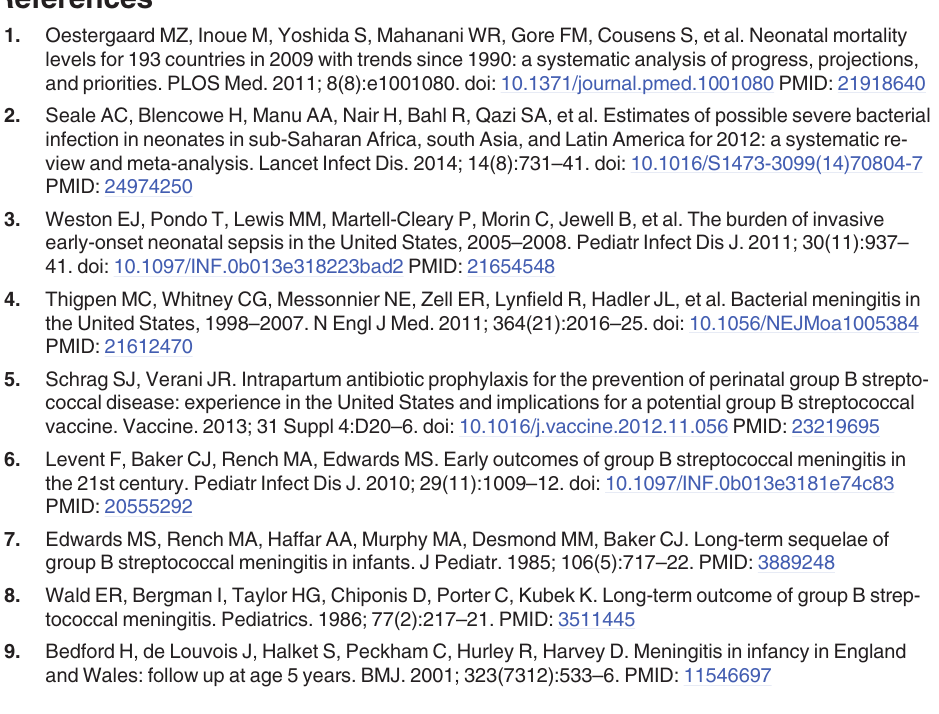
S1 Table. Risk factors for Group B streptococcus (GBS) invasive disease in HIV-infected and-uninfected mothers of GBS cases. S2 Table. Clinical and laboratory features of infants with invasive Group B streptococcal (GBS) disease. S3 Table. Baseline demographic characteristics of Group B streptococcus (GBS) cases and matched controls for 3 and 6 month